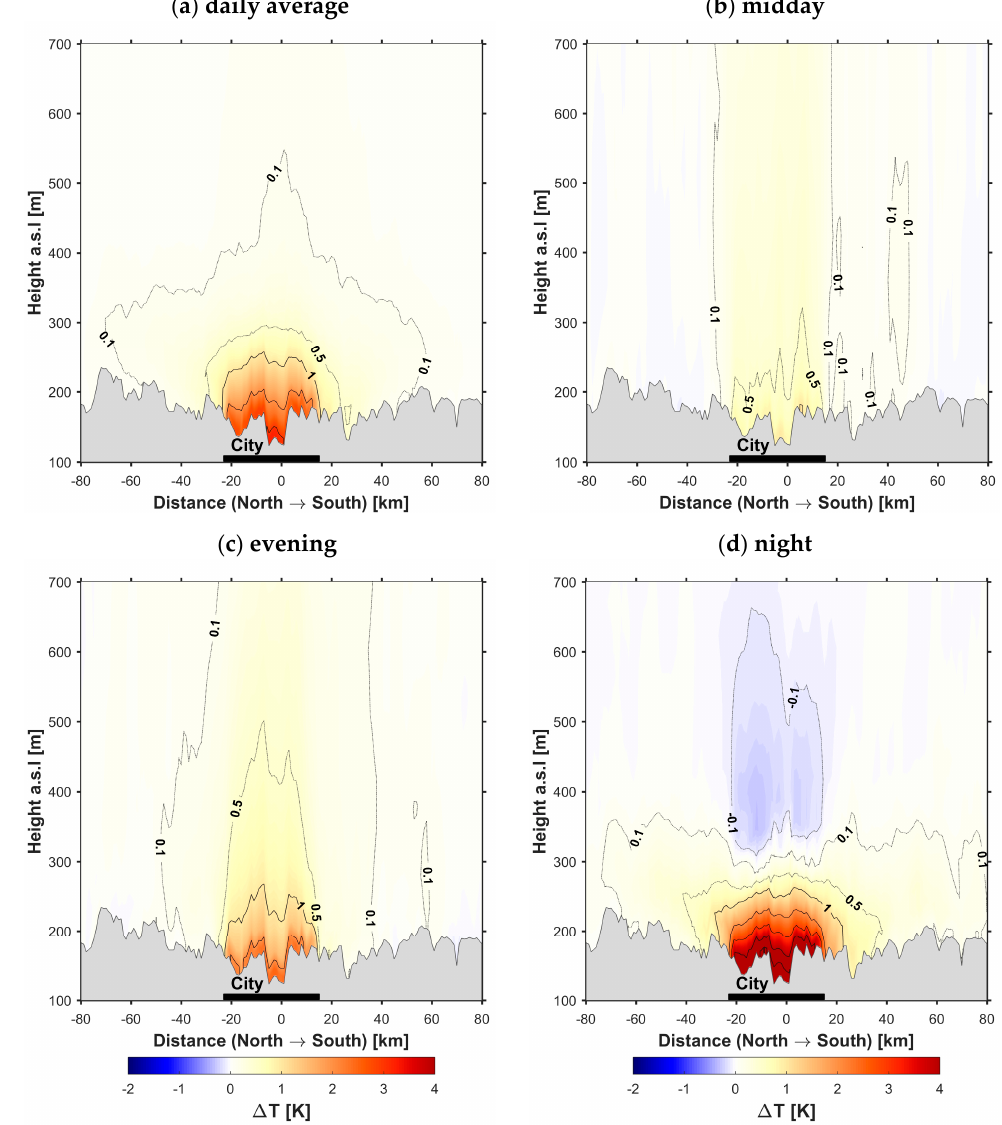
Figure 4. Vertical meridional cross-sections through the center of Moscow in the field of the modeled temperature response to switching on the urban canopy model ( ∆ T ): daily-mean ( a ); mean daytime (13 UTC/16 MSK) ( b ); evening (16 UTC/19 MSK) ( c ); and nocturnal (0 UTC/3 MSK) ( d ) values. The averaging is made for the days with intensive urban heat island during June–August 2014. The contour lines for the values higher than 1 K are indicated at each 1 K. Zero at horizontal axis is the city center (Balchug weather station, see Section 2.2). Bold black line shows the urbanized area (urban fraction higher than 25%). The vertical coordinate is elevation above the sea level (a.s.l.), gray shading represents the